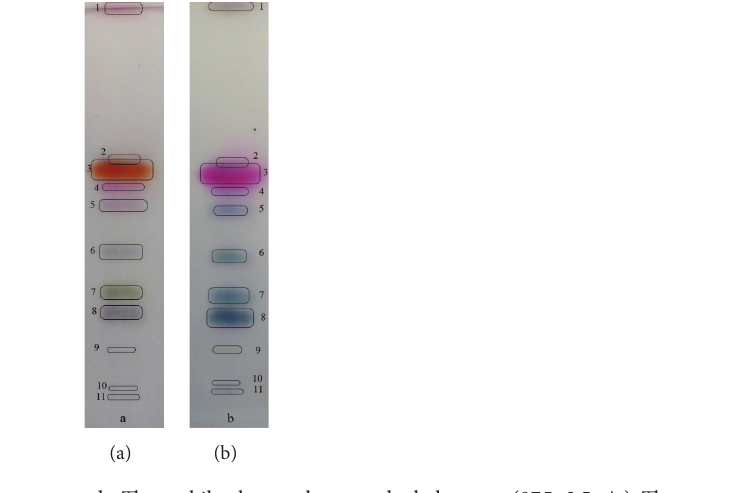
Figure 2: The 1D-TLC separation of Thymi Oleum compounds. The mobile phase: toluene and ethyl acetate (97.5: 2.5 v/v). The two modes of compounds derivatization: (a) anise aldehyde-sulphuric (VI) acid reagent and (b) vanillin in ethanol reagent.